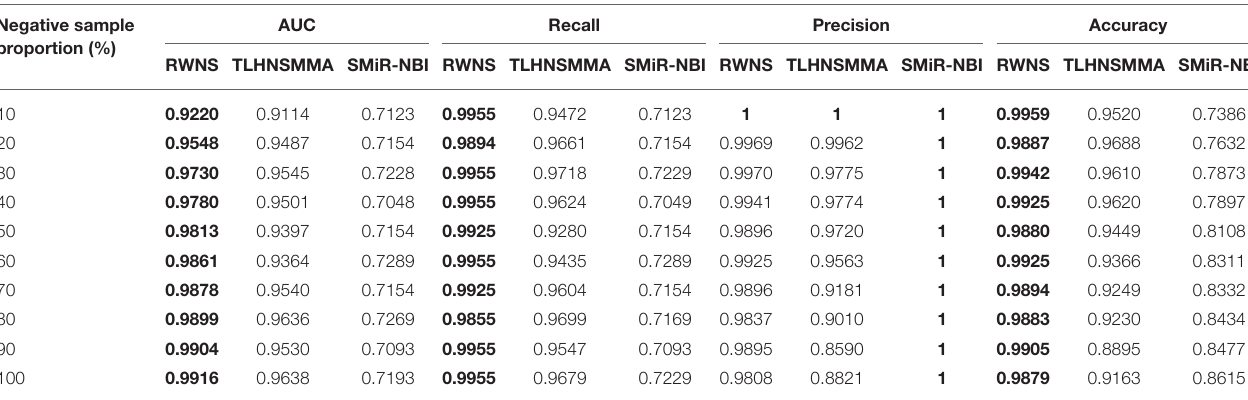
TABLE 3 | The performance comparison of RWNS, TLHNSMMA, and SMiR-NBI under 5-fold cross validation in SM2miR1. Negative sample proportion